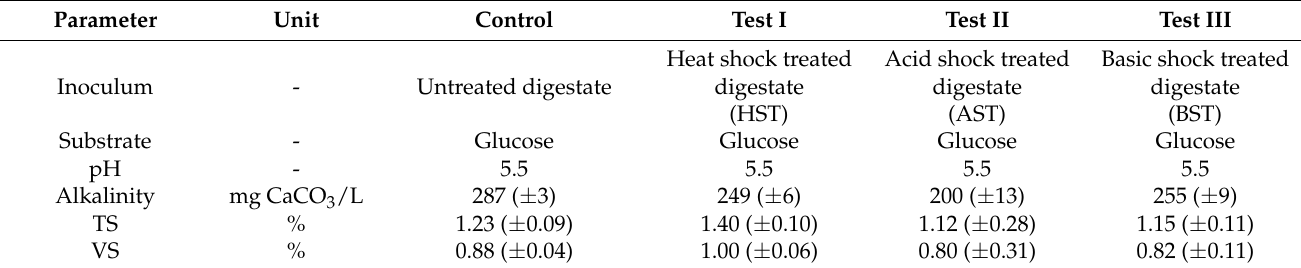
Table 1. Characterisation results for all reactors on Day 0 for BHP